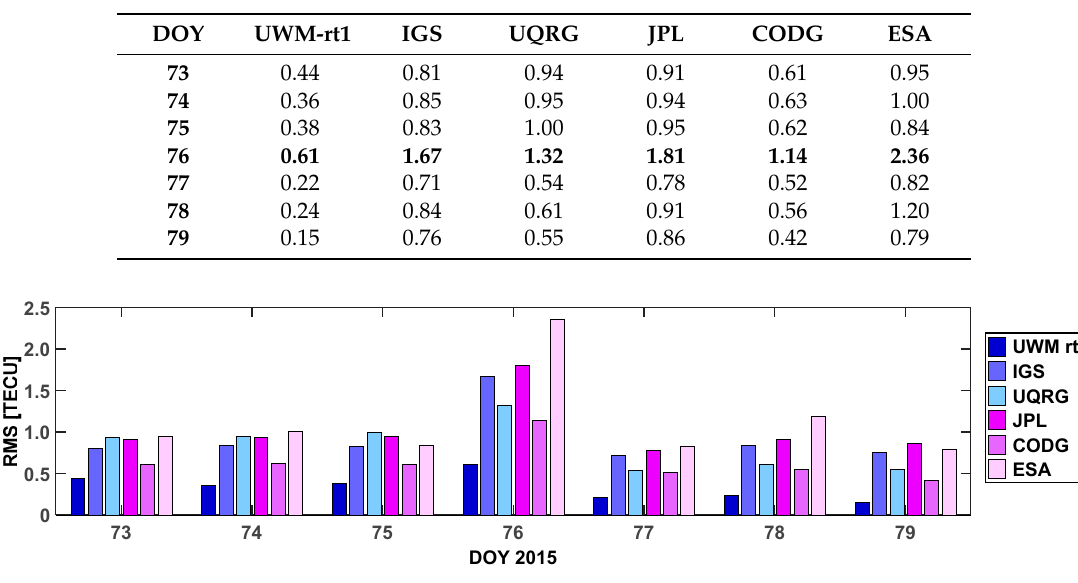
Figure 7. Daily RMS distribution for all analyzed TEC maps (TECU).